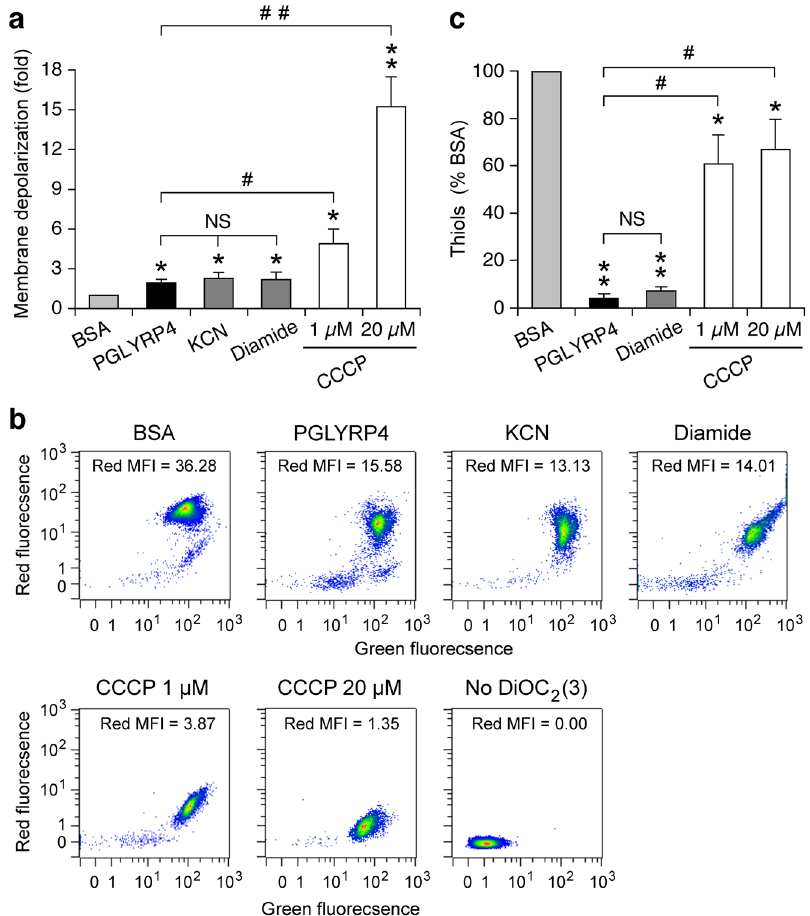
Figure 9. Comparison of membrane depolarization and thiol depletion in B. subtilis . B. subtilis 168 was treated with BSA, PGLYRP4, KCN, diamide, or CCCP as indicated for 30 min. ( a ) Membrane depolarization was measured by flow cytometry with membrane potential sensitive dye DiOC 2 (3) and the results are the ratios of mean red fluorescence intensity in BSA/treated cells. ( b ) Representative dot plots with mean fluorescence intensities (MIF). ( c ) The amounts of thiols expressed as percent of control with BSA (100%). ( a , c ) means ± SEM from 6 experiments (biological replicates); * P < 0.05, ** P < 0.001, PGLYRP4, KCN, diamide, or CCCP vs BSA; NS not significant ( P > 0.05); # P < 0.05, ## P < 0.001 as indicated by